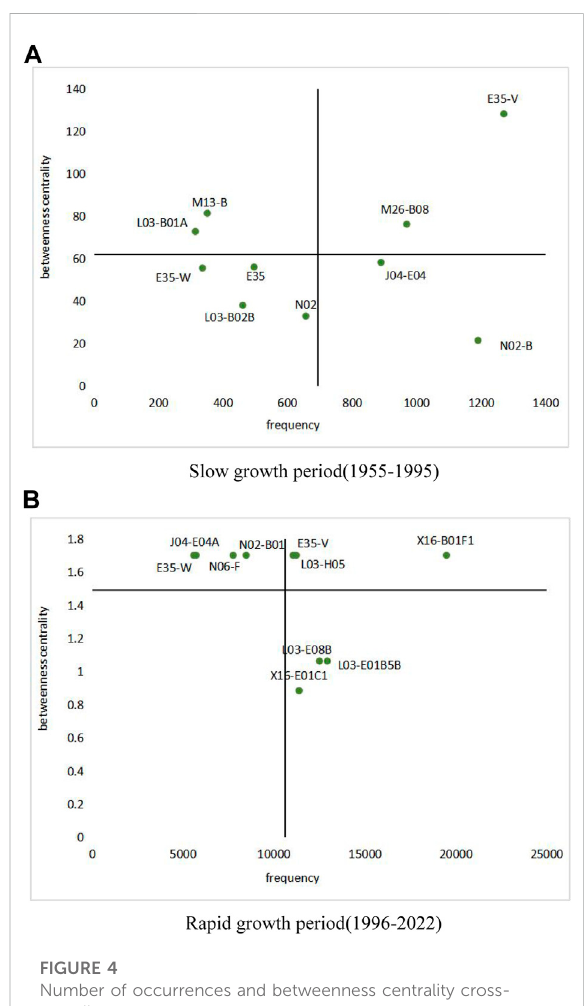
FIGURE 4 Number of occurrences and betweenness centrality cross-